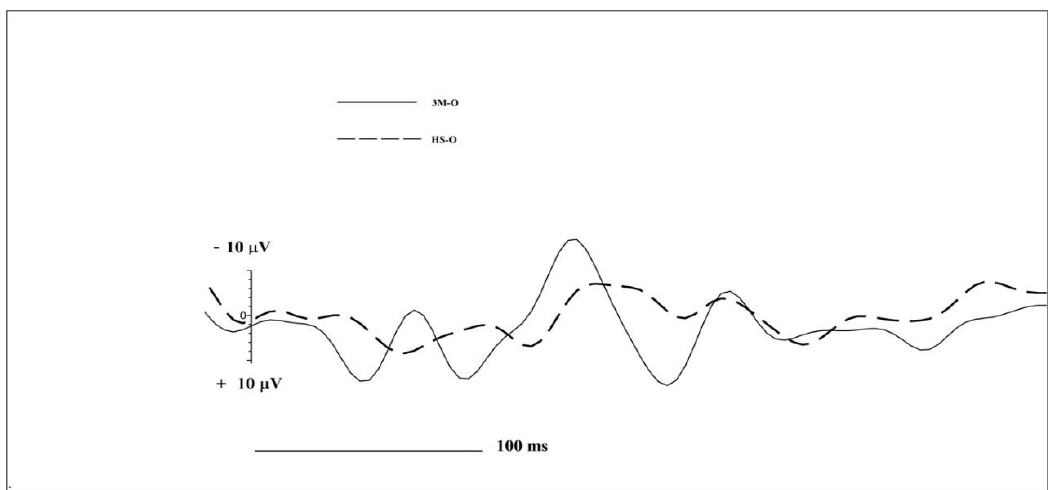
Figure 1. Central left Region of Interest (ROI) comparison of Chemosensory Event Related Potentials (CSERPs) components for 3M-O (black continuous line) and HS-O (dashed line) subjects. Brain Sci. 2019 , 9 , x FOR PEER REVIEW For N1, the 3M-N twins showed increased amplitude in frontal right (3M-N -9.32 µV vs HS-N - 2.38 µV), central left (3M-N -7.68 µV vs HS-N-5.76 µV), Cz (3M-N -16.02 µV vs HS-N -11.80 µV) and Fz (3M-N -8.95 µV vs HS-N -6.67 µV). N1 latencies were faster in the frontal left (3M-N 121 ms vs HS- N 203 ms), central left (3M-N 121 ms vs HS-N 168 ms), temporal left (3M-N 297 ms vs HS-N 316 ms), temporal right (3M-N 207 ms vs HS-N 270 ms), Fz (3M-N 160 ms vs HS-N 250 ms) and Pz (3M-N 164 ms vs HS-N 188 ms) in 3M-N.